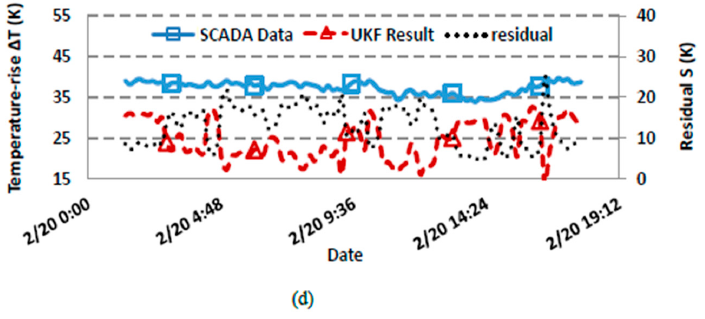
Figure 11. Comparison of UKF prediction and SCADA data in fault, 2007. ( a ) Wind speed; ( b ) Rotor speed; ( c ) Output power; ( d ) Temperature rise.